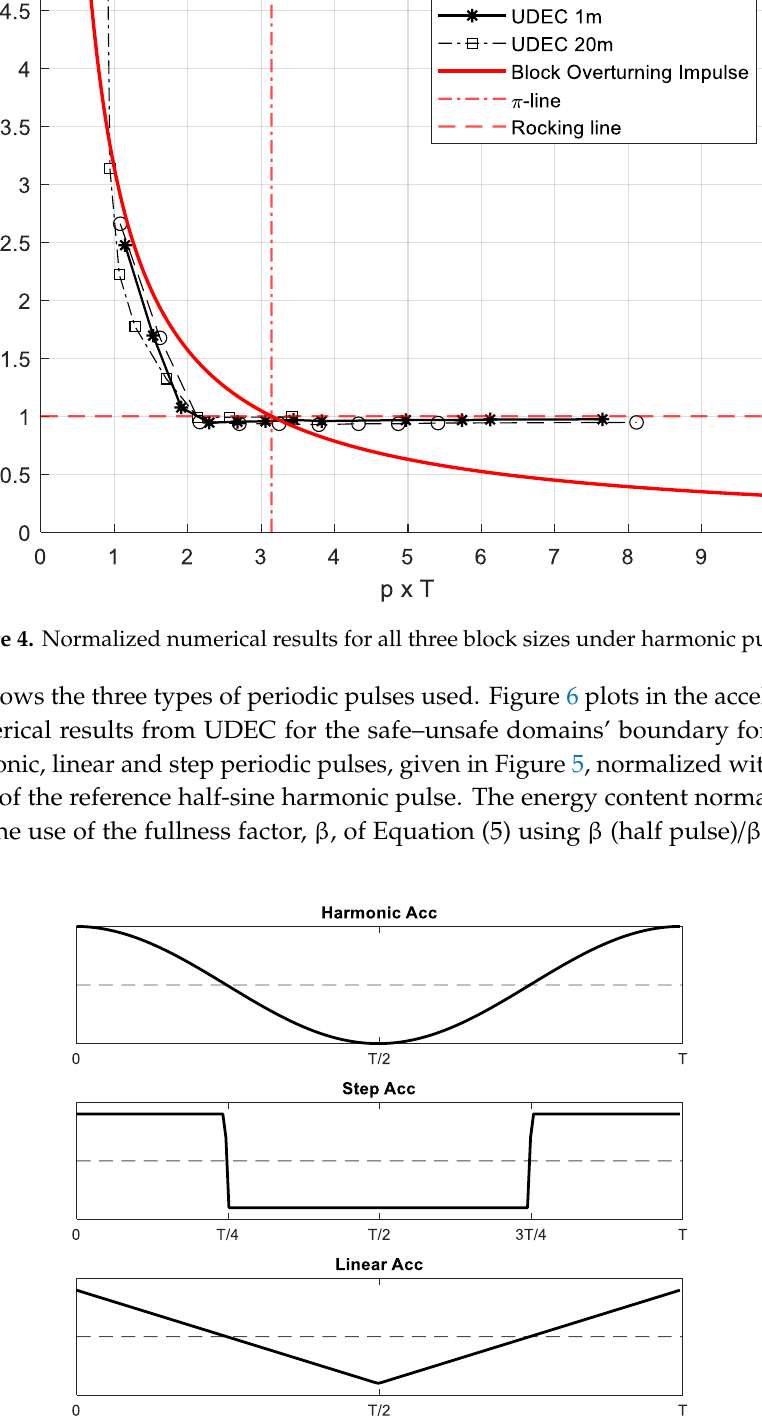
Figure 6. Normalized numerical results for all three types of pulses for the 1 m block. 4. Discussion The responses of 0.5 m and 1 m blocks to harmonic pulses presented in Tables 1 and 2 show clearly two modes of response as predicted by the theory. The numerically observed transition periods, around 0.4 and 0.6 s for the 0.5 and 1 m blocks, respectively, fall consistently below the theoretically predicted transition periods of 𝑇̅ (0.5 m column) = 0.580 s, 𝑇̅ (1 m column) = 0.821 s; for comparison 𝑇̅ (20 m column) = 3.67 s. This is also shown in the normalized graphs of Figure 4 where the normalized transition period falls around pT = 2 for the numerical simulation while pT = π theoretically. Periodic pulses with periods less than the transition period of the block have high acceleration that can drive rocking; this rocking becomes unstable if the minimum energy condition is met. At higher periods (that are larger than the transition period), the energy of the pulse is much higher